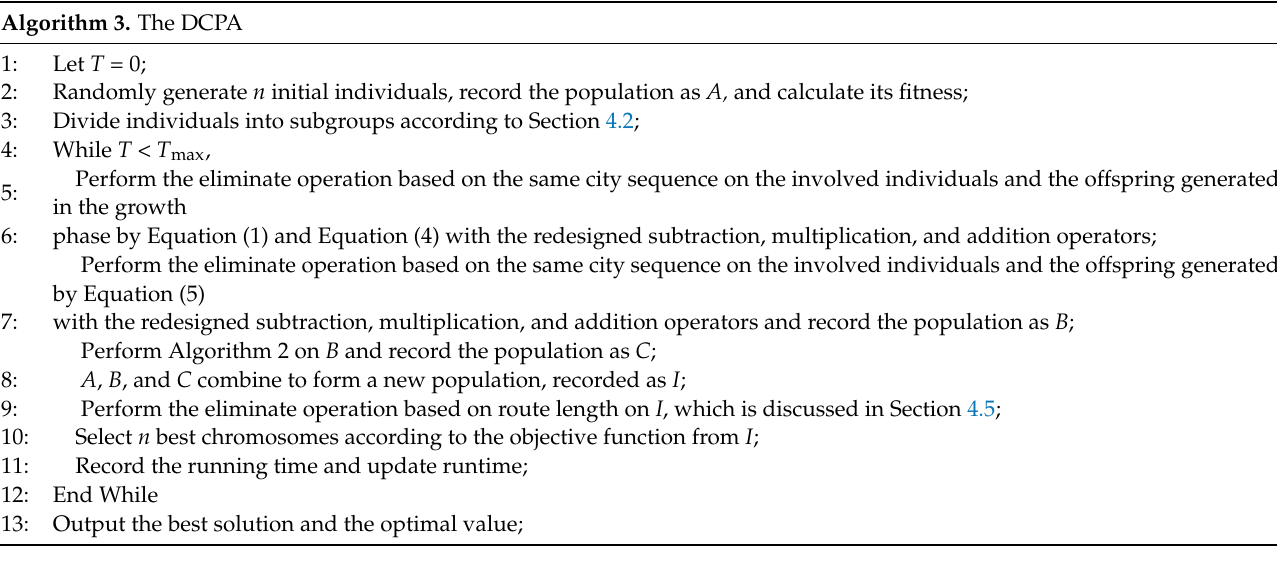
Algorithm 3. The DCPA